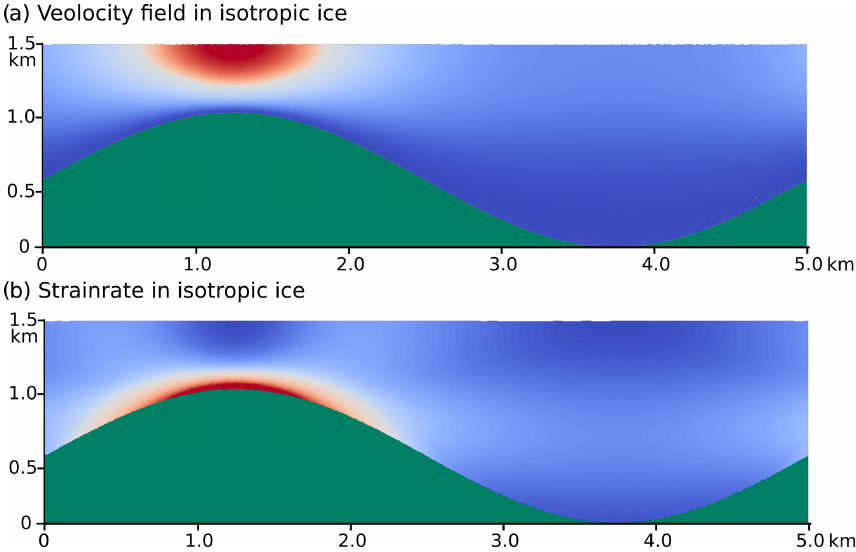
Figure 10. Velocity field and strain rate field in isotropic ice. Large strain rates and velocities occur in the vicinity of the bottleneck formed by the crest of the hill. Green: bedrock. For velocity, red is 70ma − 1 and blue is 0ma − 1 . For strain rate, red is 0.032a − 1 , and blue is 0a − 1 .